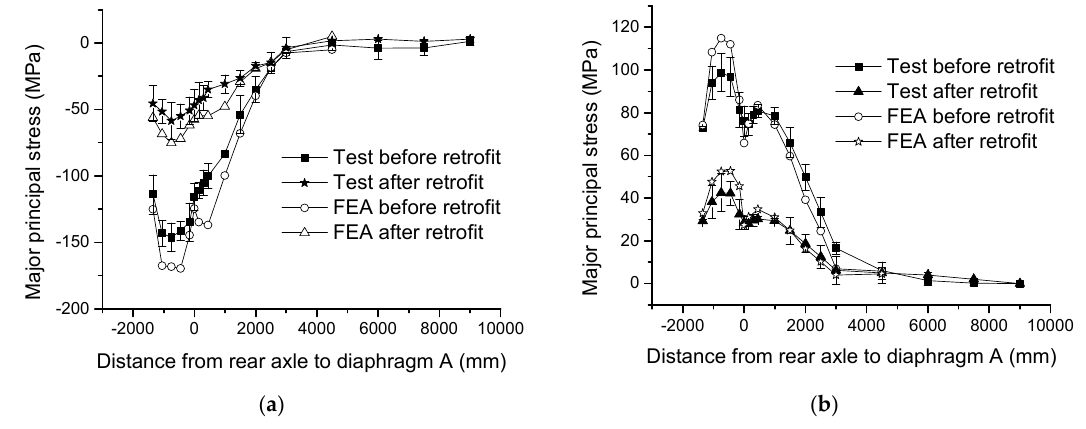
Figure 17. Stress spectra of diaphragm cutouts for a longitudinally moved vehicle: ( a ) stress spectra of zone A, ( b ) stress spectra of zone B.